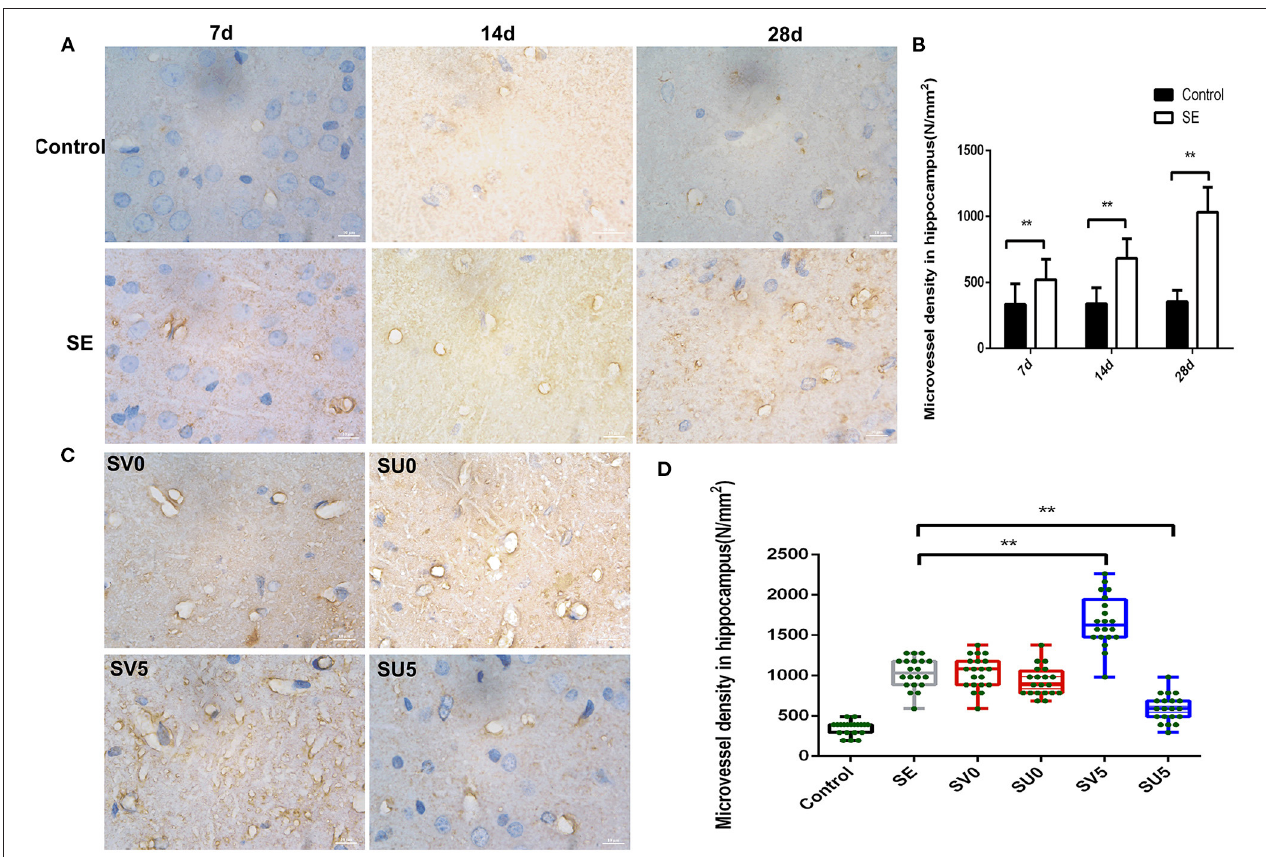
FIGURE 4 | Effect of VEGF on microvascular regeneration during epileptogenesis after SE. (A) Expression of CD31 in the hippocampus after SE (1,000 × , scale bar: 10 µ m). (B) MVD in the hippocampus after SE (N/mm2). The MVD in the SE group was significantly higher at each time point than that in the control group, ** P < 0.01. (C) Effect of VEGF intervention in different phases after SE on microvascular regeneration (1,000 × , scale bar: 10 µ m). (D) MVD in the hippocampus after VEGF intervention in different phases after SE. The MVD of SV5 was much higher than that of the SE group; however, the MVD of SU5 was much lower than that of the SE group. ** P < 0.01, n = 5 for each group. SV, VEGF injection; SU, application of a VEGFR2 inhibitor.